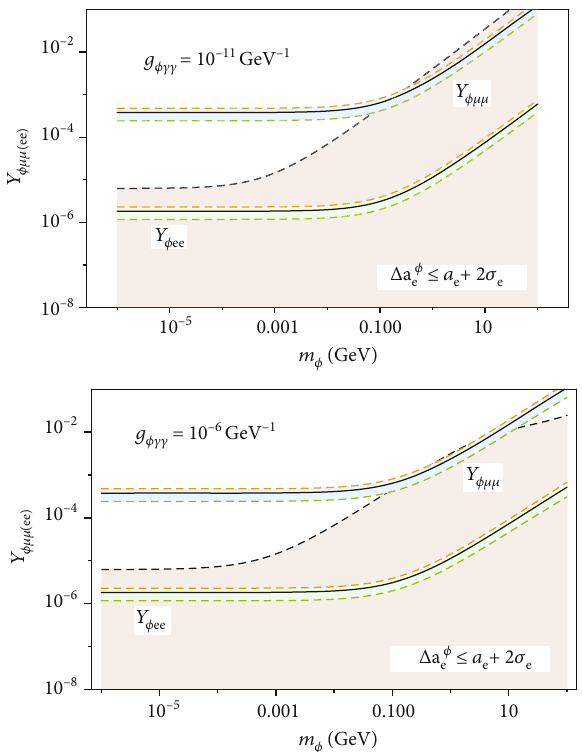
Figure 4: The 2 σ bands corresponding to the allowed region for e and μ for the scalar case at the two benchmark points with g ϕγγ = 10 − 11 GeV − 1 (top) and 10 − 6 GeV − 1 (bottom). The brown region corresponds to Δ a and green bands Y ϕμμ / Y ϕ